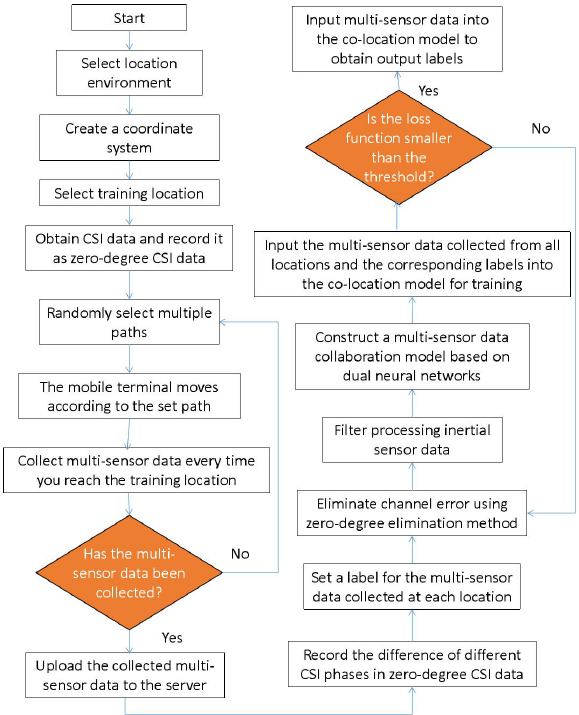
Fig. 2. The positioning process of multi-sensor co-location technology based on dual neural networks